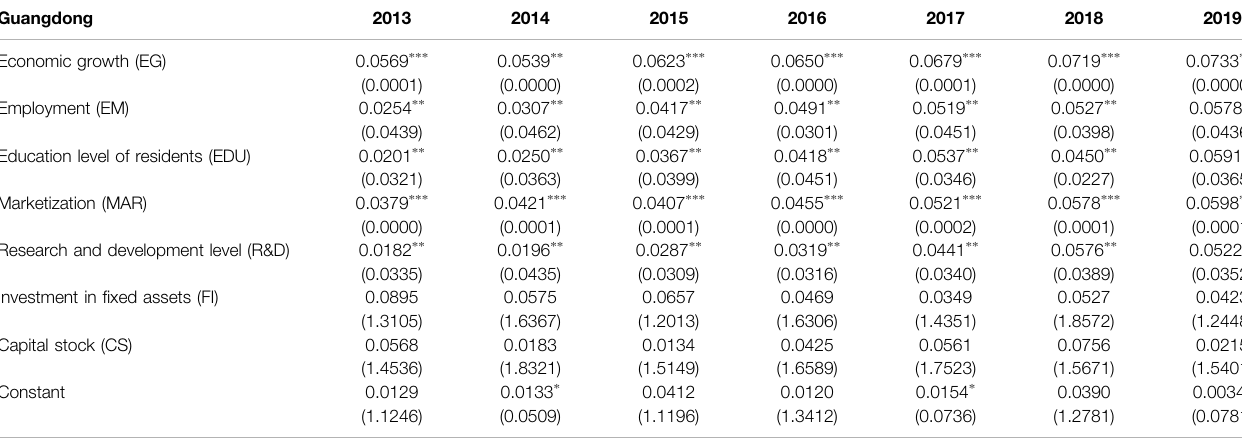
TABLE 14 | Driving force of Guangdong health tourism industry convergence.